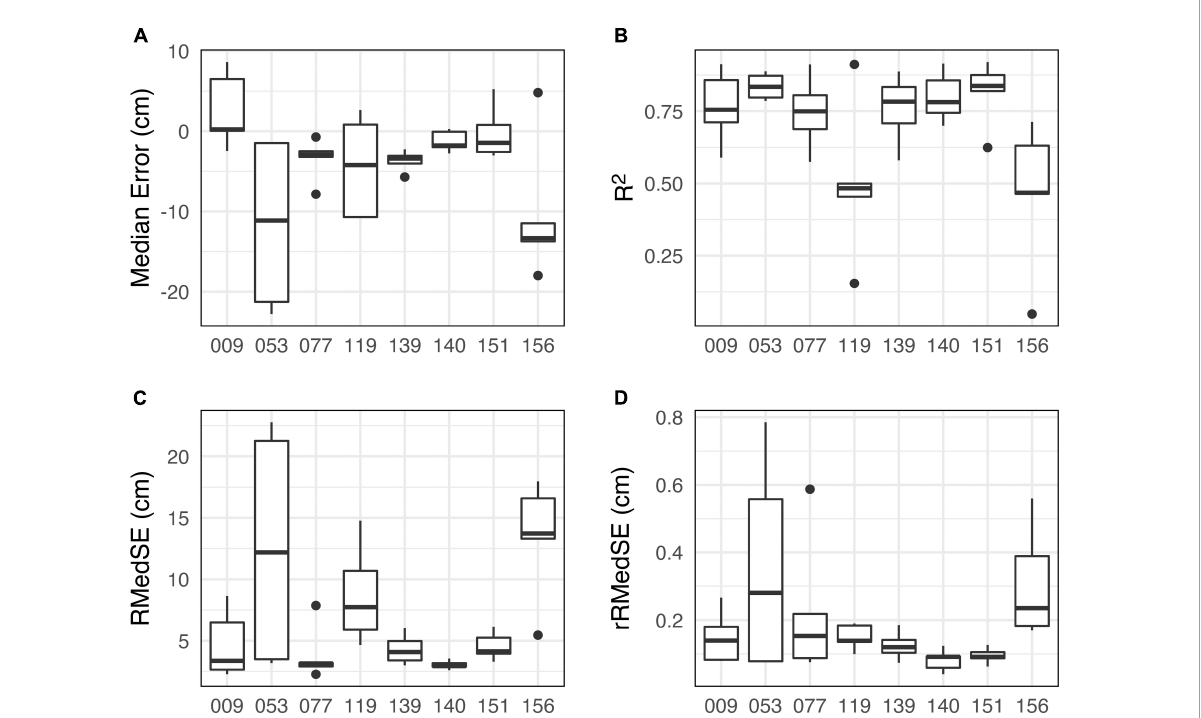
FIGURE3 Wetland model performance metrics. Individual metrics were calculated for each site-year combination for all withheld test years (control and treatment conditions) and are presented within sites. Evaluated metrics include median error (A) , R 2 (B) , root median squared error (RMedSE, C ), and root median squared error relative to the annual range of daily wetland water level within that year (rRMedSE, D ).